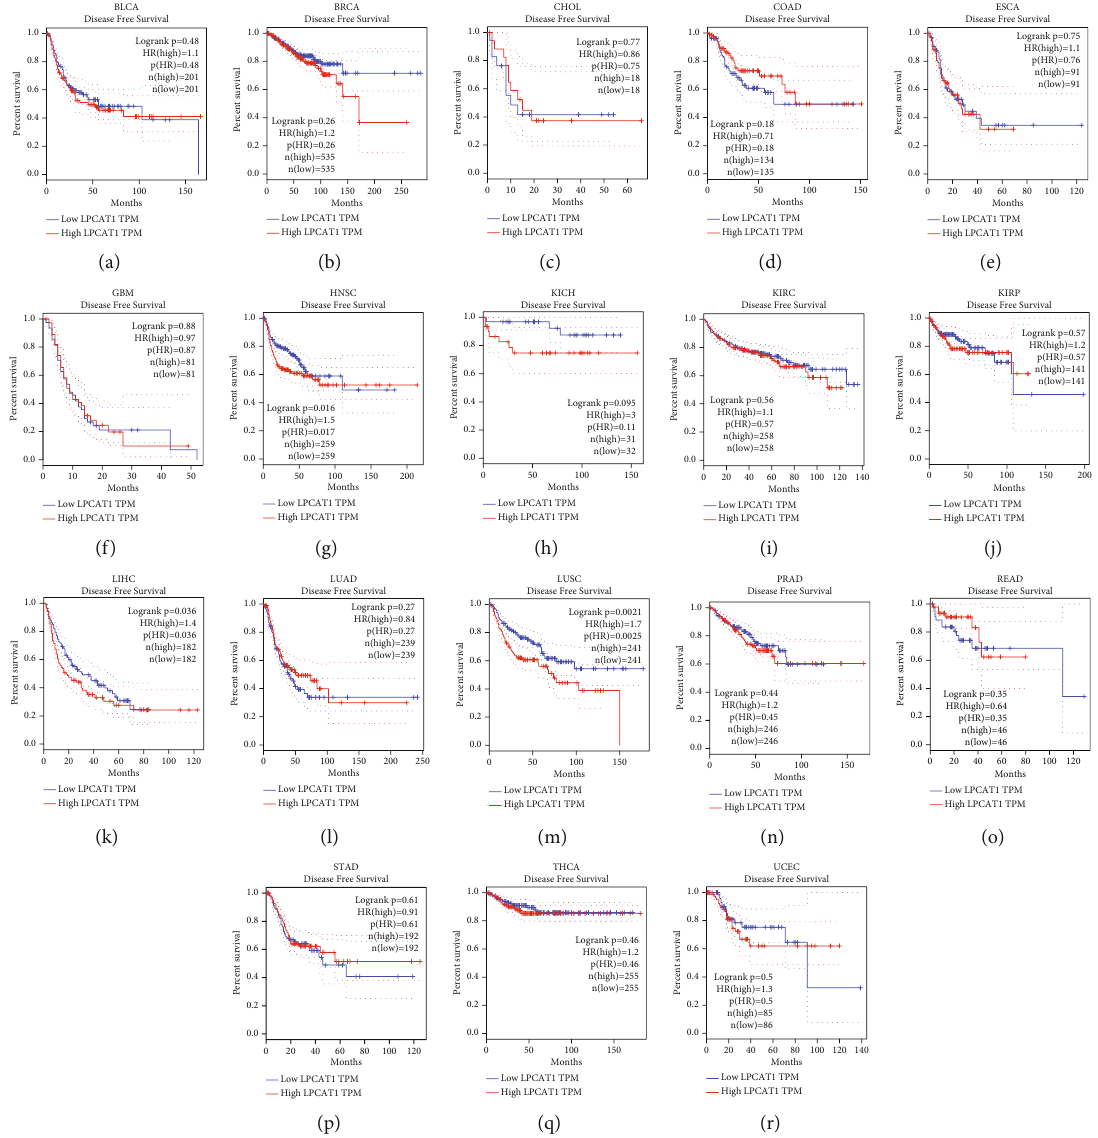
Figure 3: The disease-free survival (RFS) analysis for LPCAT1 in various human cancers determined by the GEPIA database. (a) – (l) The OS plot of LPCAT1 in BLCA (a), BRCA (b), CHOL (c), COAD (d), ESCA (e), GBM (f), HNSC (g), KICH (h), KIRC (i), KIRP (j), LIHC (k), LUAD (l), LUSC (m), PRAD (n), READ (o), STAD (p), THCA (q), and UCEC